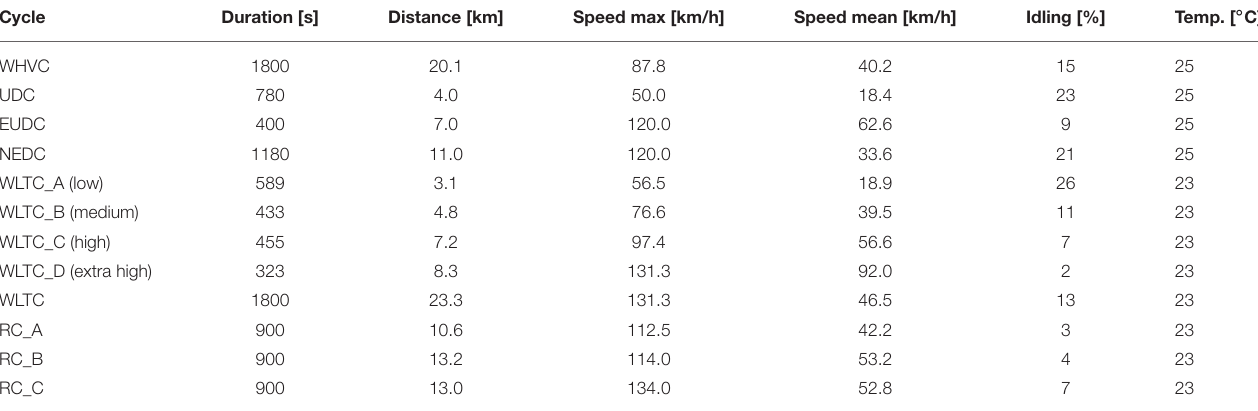
TABLE 2 | Characteristics of driving